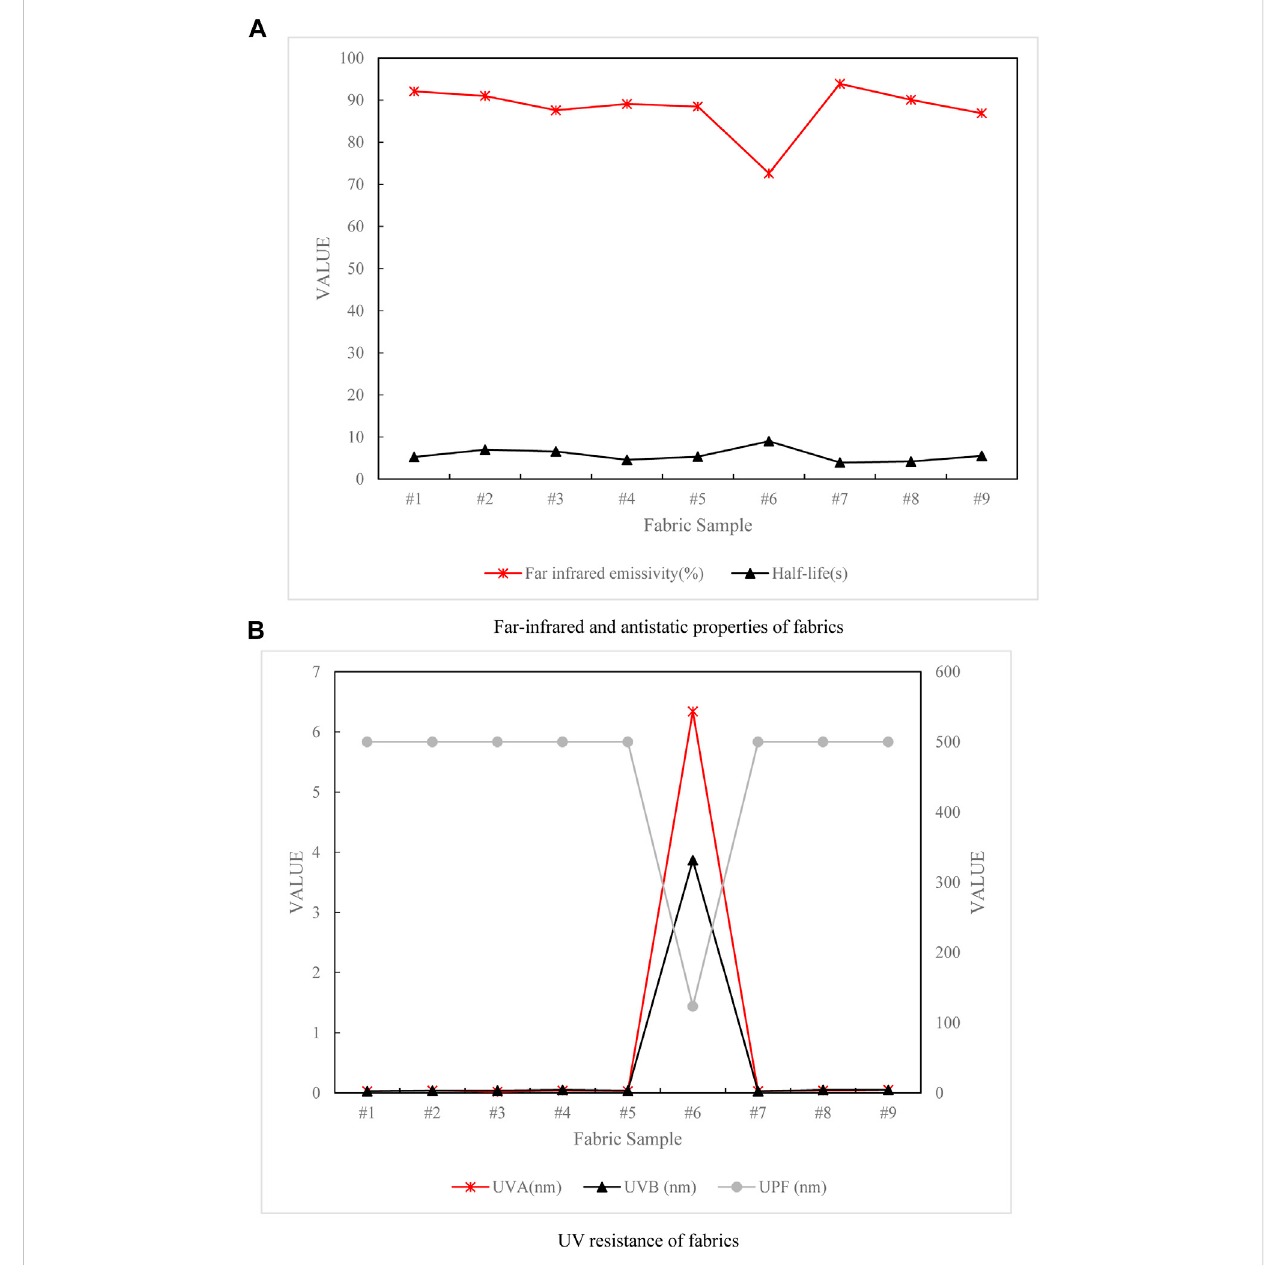
FIGURE 5 Functional test results of the fabric. (A) . Far-infrared and antistatic properties of fabrics. (B) . UV resistance of